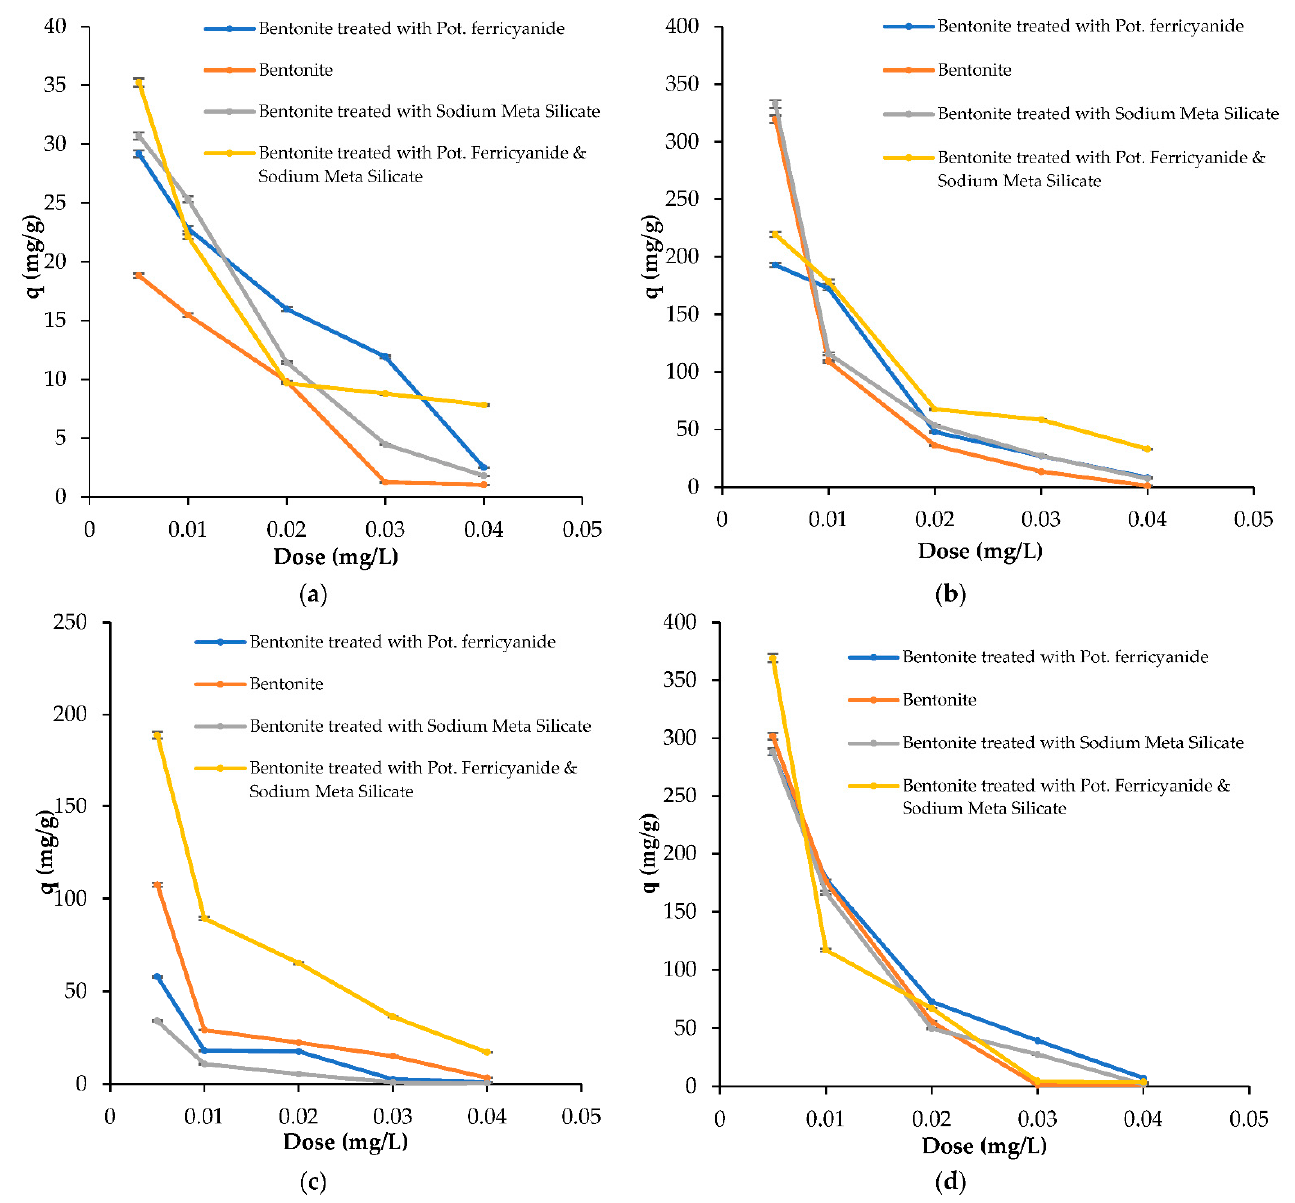
Figure 3. Adsorption capacities of adsorbents for ( a ) Reactive red, ( b ) Direct violet-51, ( c ) Acid red, and ( d ) Reactive green-5 dyes at different adsorbent dosage.